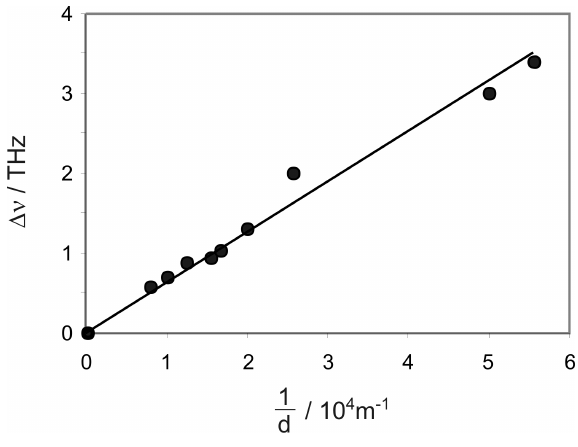
Figure 4. Dependence of the WGM peak separation on sensor fibre diameter. A linear fit to the data forced through the origin has a slope of 6.31 × 10 7 , compared with a value of 6.53 × 10 7 predicted by Equation 6.